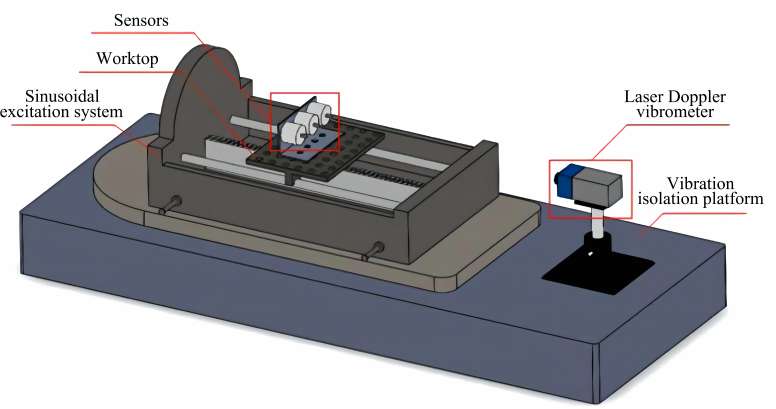
Figure 13. Schematic diagram of the comparative experimental